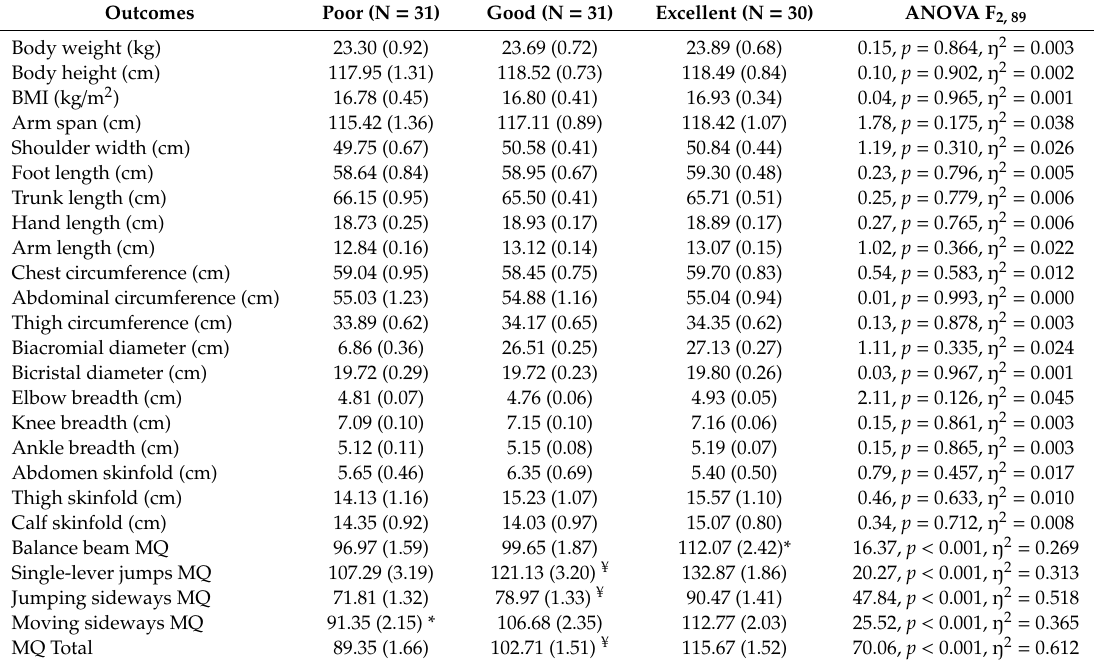
Table 3. Di ff erence in the anthropometric (AM) and motor competence (MC) variables across the swimming ability group